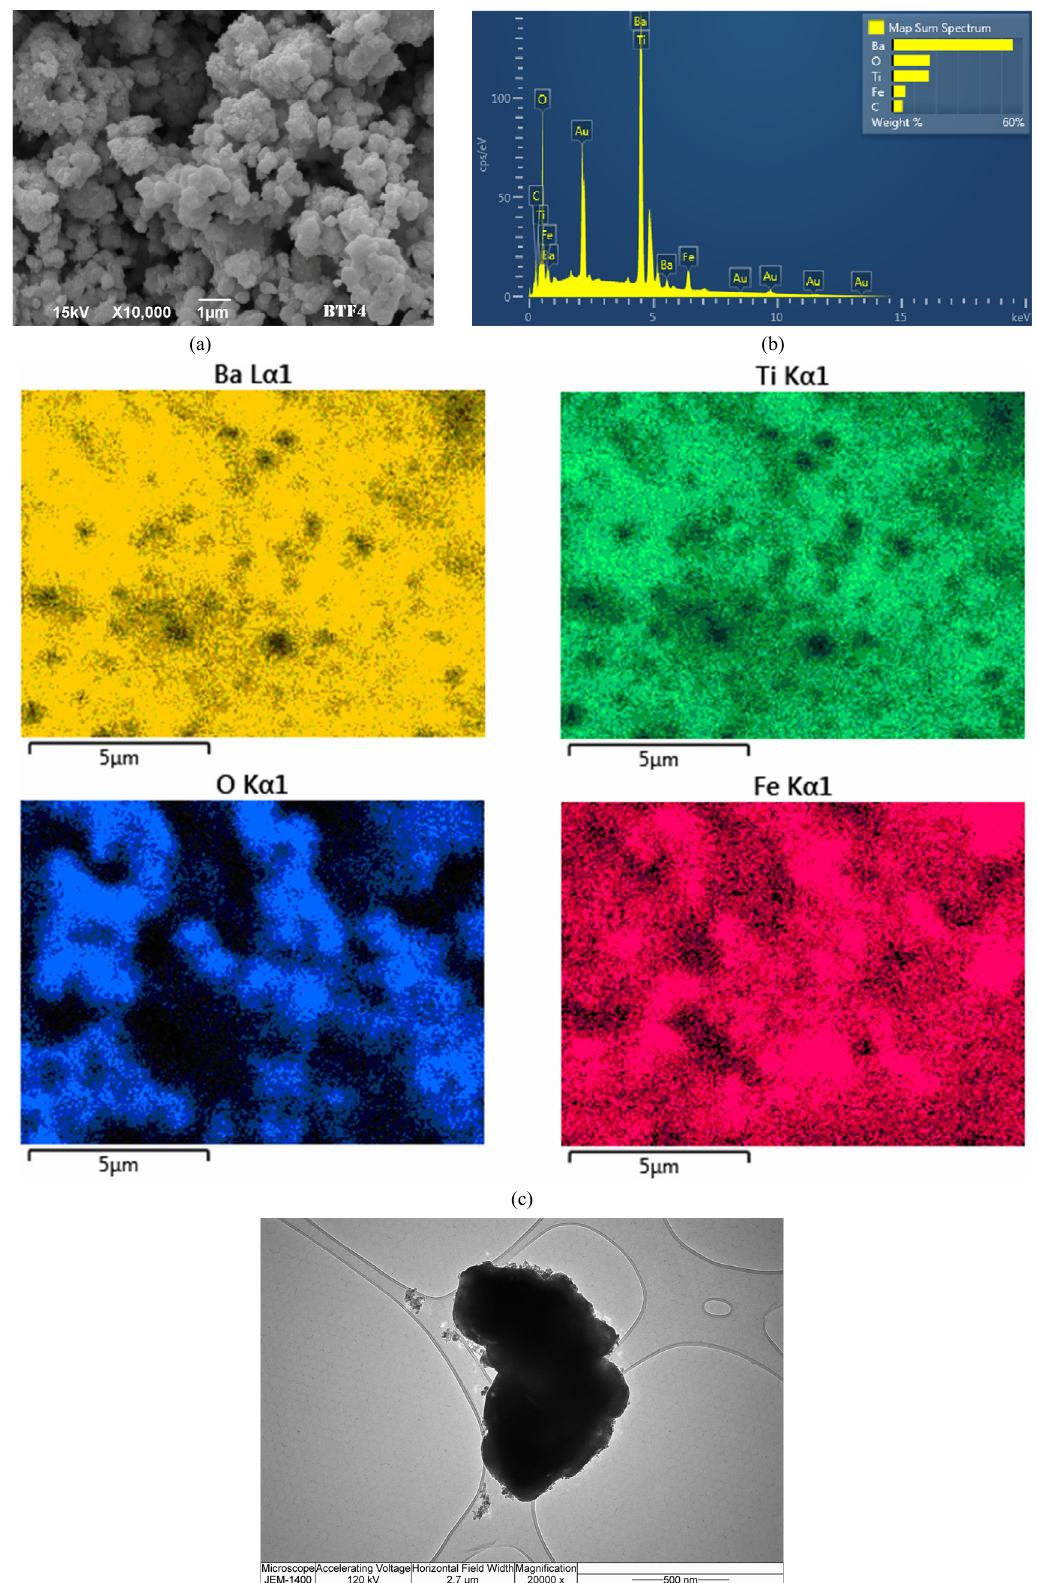
Fig. 7 (a) SEM; (b) EDS; (c) mapping of elements; (d) TEM for the sample